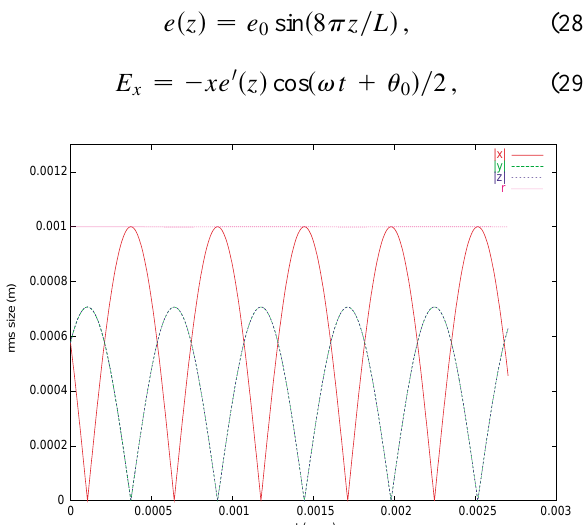
FIG. 1. (Color) The position and radius of the rotating particle as a function of time.